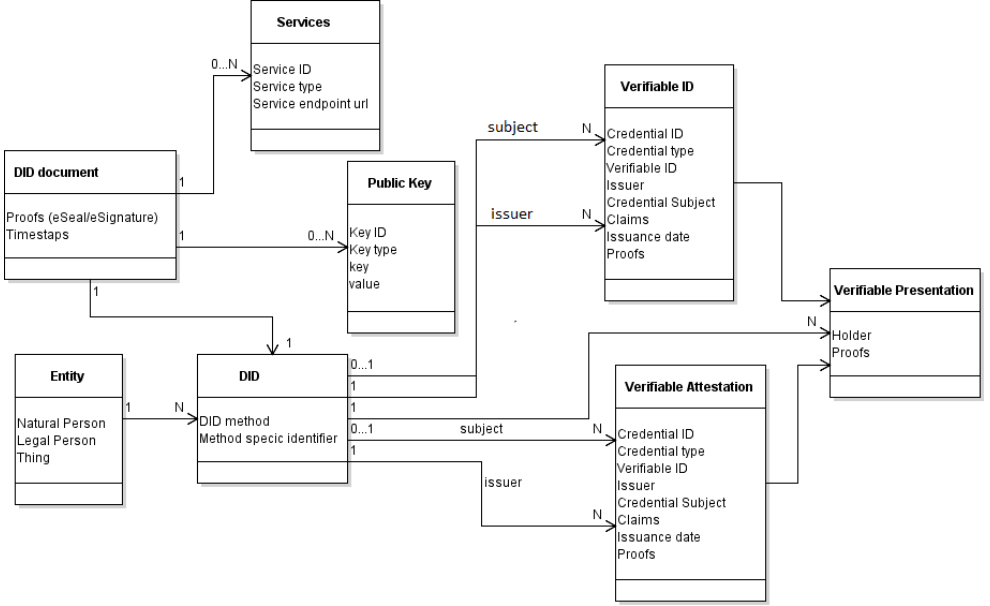
Figure 1. SSI data model proposed by